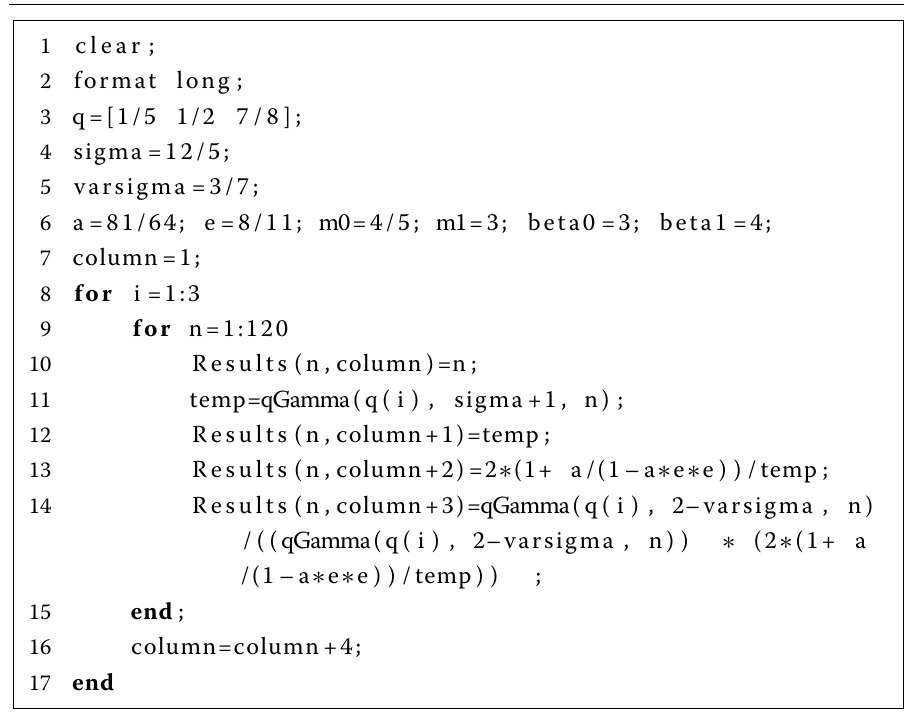
Algorithm 2 MATLAB codes for Example